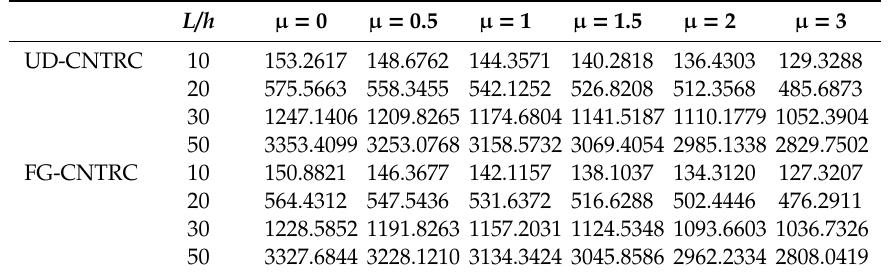
Table 7. E ff ect of the slenderness ratio L / h on the nondimensional critical buckling load for C-S CNTRC = 0.14. curved beams with α = π / 3, V ∗ CNT